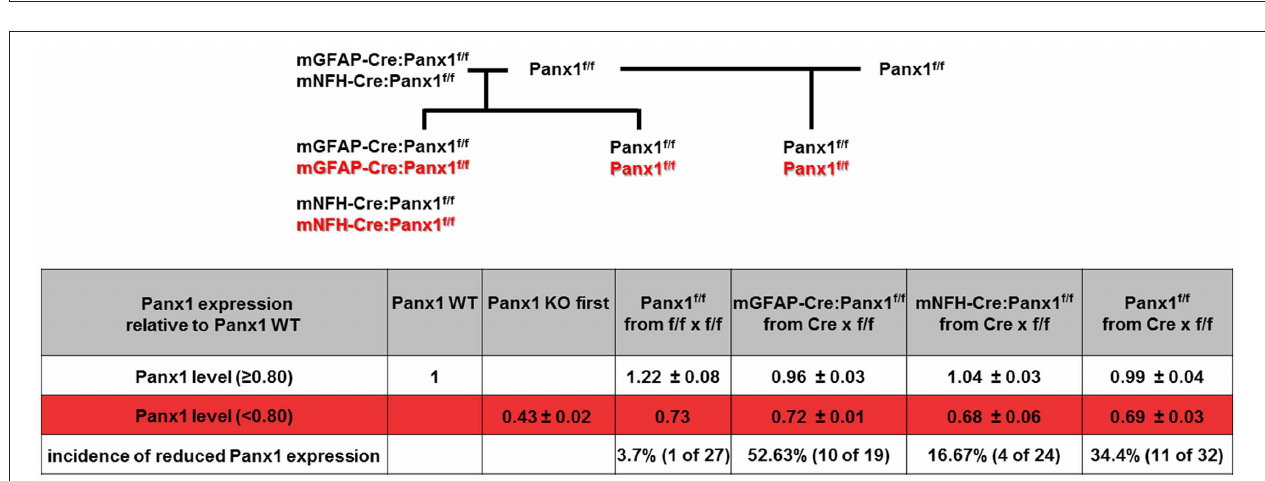
conditional Panx1 knockout and in Panx1 f / f mice, which were generated as shown in top part. Animals were considered to have ectopic Cre activity if they showed less than 80% of Panx1 mRNA expression compared to that found in WT